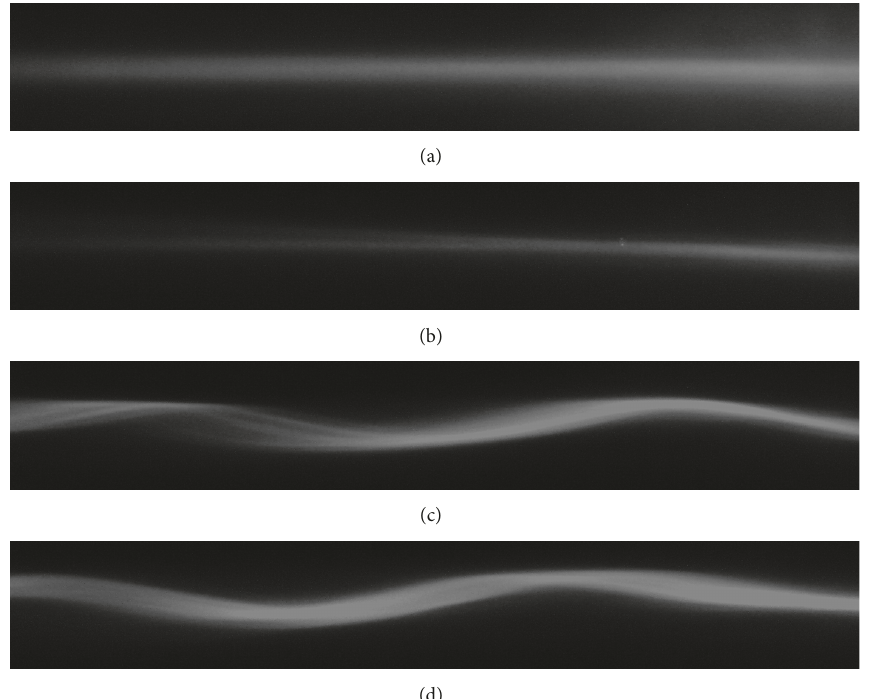
Figure 2: The guided light in a single channel by applying external voltages of (a) 0 V, (b) 1.5 V, (c) 2.2 V, and (d) 3.0 V.